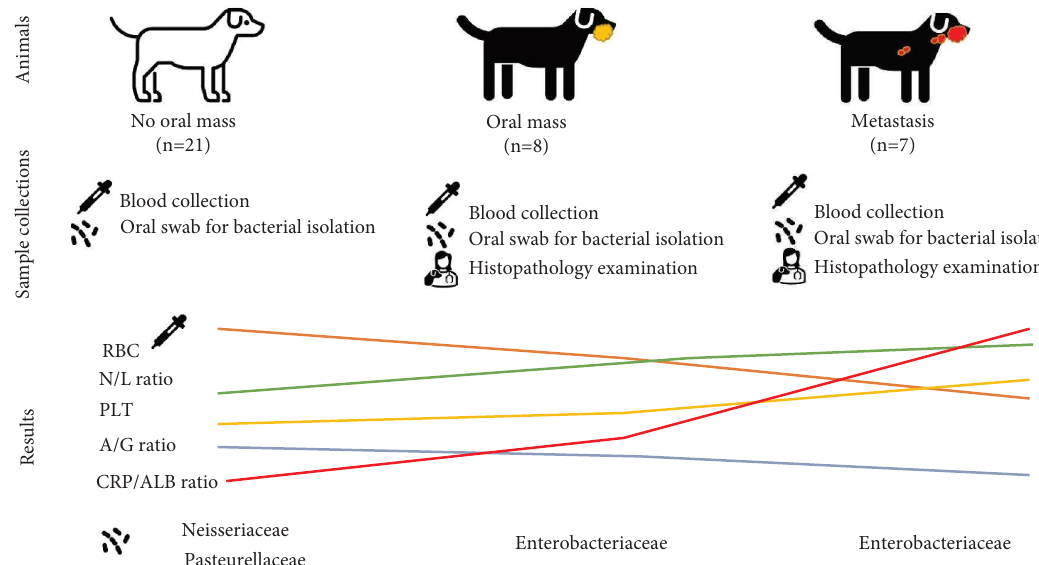
Figure 9: Te layout of animals, sample collections, and the interesting results in this